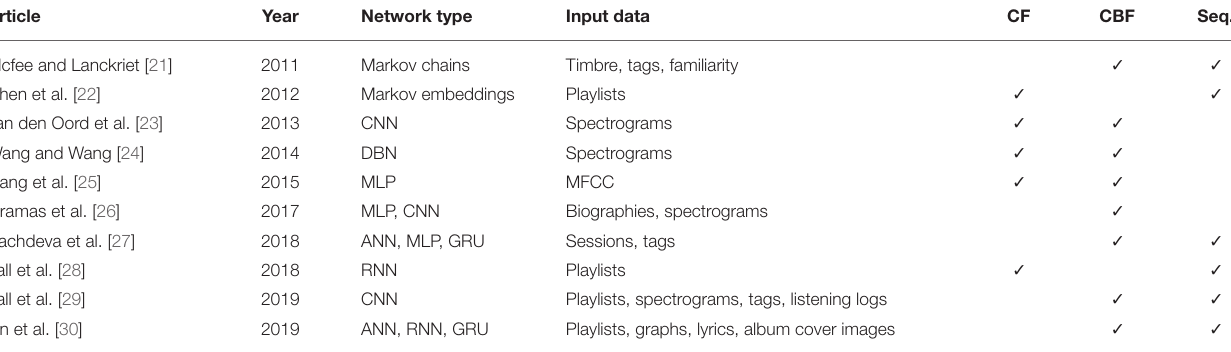
TABLE 1 | Overview of discussed research articles.